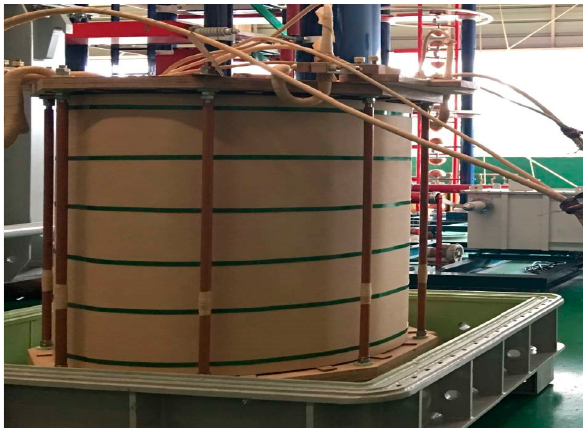
Figure 8. The prototype of the coupling reactor.